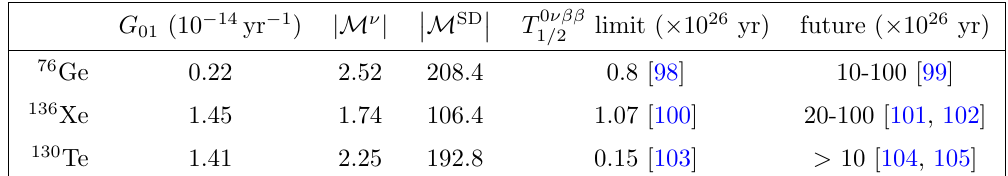
Table 2 . Values of the phase-space factors G 01 and nuclear matrix elements for di(cid:11)erent nuclear isotopes. The values of G 01 are obtained from [96, 106] (see also [107, 108]). (cid:23) The nuclear matrix elements (NMEs) are the averaged best estimates from ref. [109]. The jM j (cid:12) SD (cid:12) (cid:12) are the values given in ref. [110] from their computation using the proton-neutron NMEs (cid:12) M quasiparticle random phase approximation (pn-QRPA) approach. For 76 Ge and 136 Xe they are found to agree to better than 30% with the NME computation from [96] using the interacting shell model (ISM), while for 130 Te there is roughly a factor two mismatch with ISM. The last two columns show the current best limit on T 0 (cid:23)(cid:12)(cid:12) for each isotope, as well as the approximate reach of 1 = 2 planned experiments for this